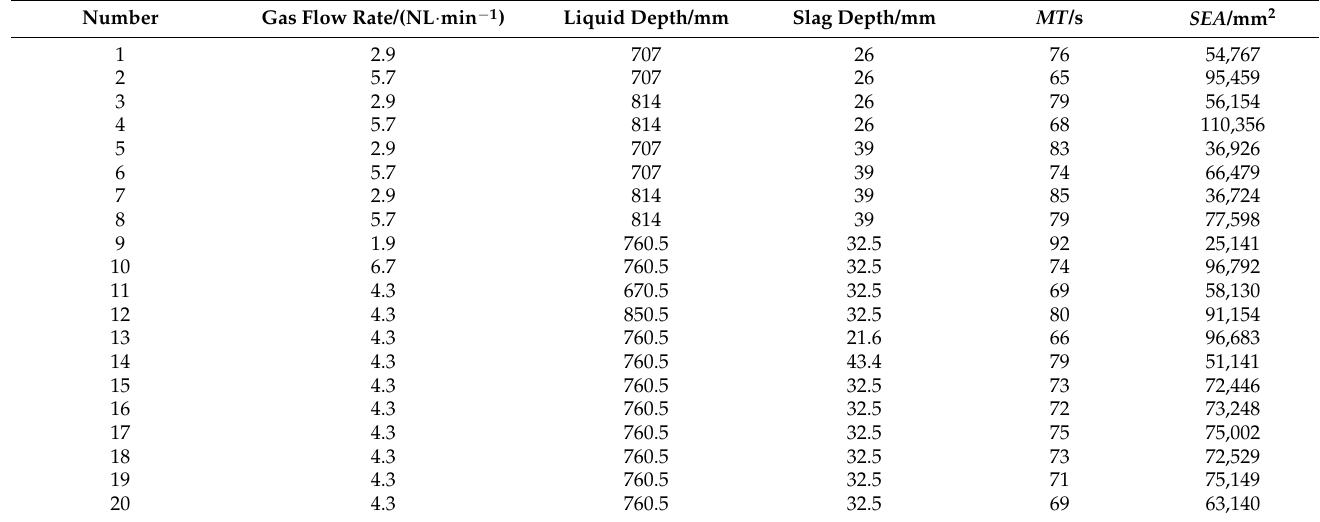
Table 7. Experimental design and results.